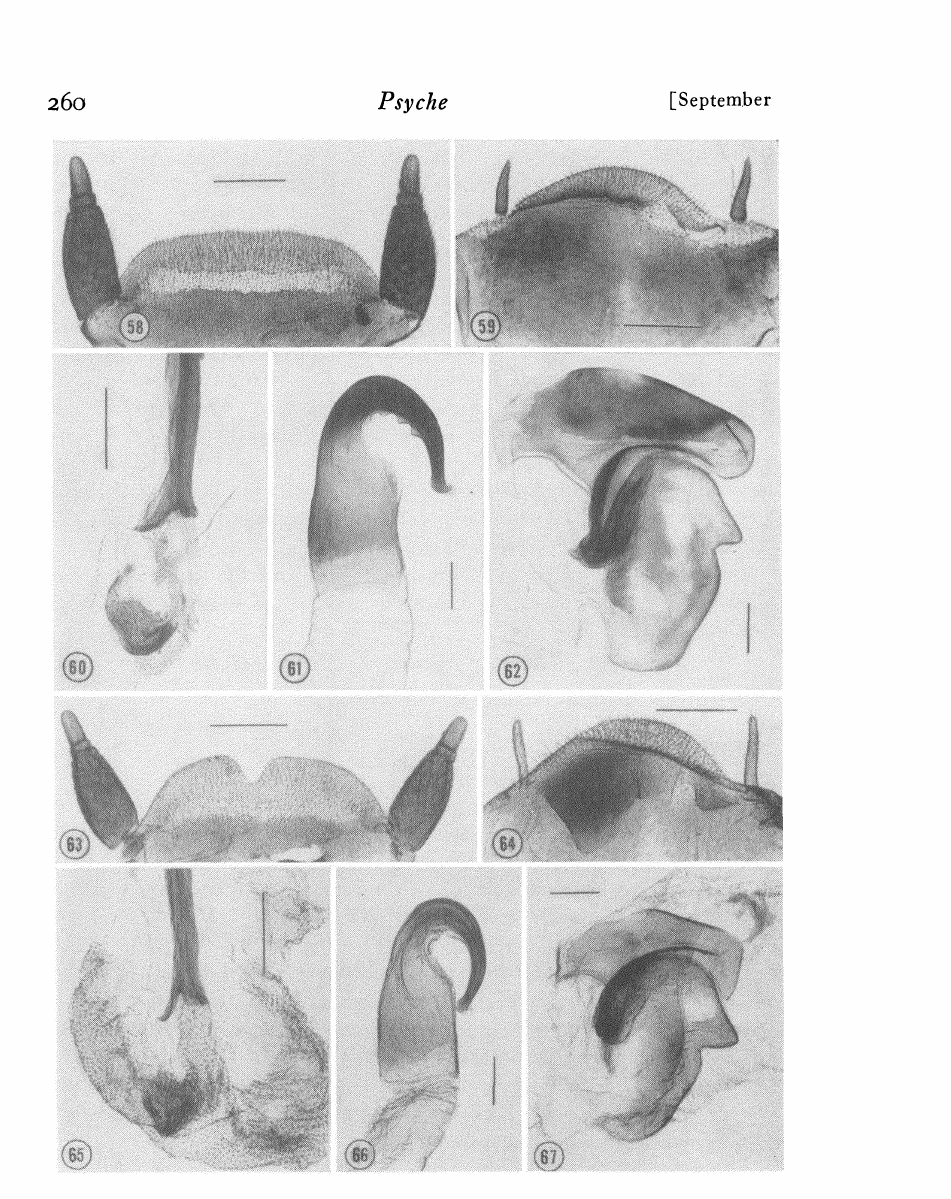
Figs. 58-67. Supra-anal and subgenital plates, and genital phallomeres of male Diploltera spp. 58-62. D. punctata (from laboratory colony originating in Hawaii). 58. Supra-anal plate (dorsal). 59. Subgenital plate (ventral). 60-62. Genital phallomeres. 63-67. (67 BMNH). D. sp., Honolulu, Hawaii. 63. Supra-anal plate (dorsal). 64. Subgenital plate (ventral). 65-67. Genital phallomeres. (scale" supra-anal and subgenital plates 0.5 mm; phallo- meres 0.2